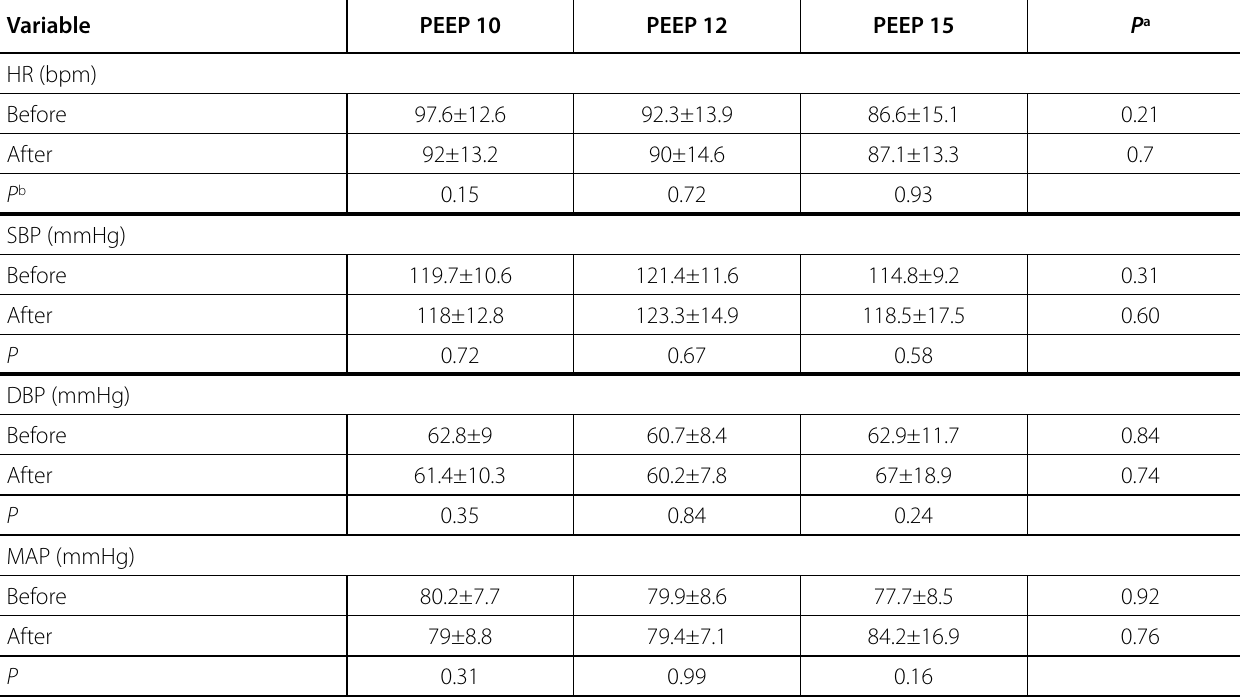
Table 4. Hemodynamic impact of lung re-expansion therapy in patients undergoing cardiac surgery. Variable